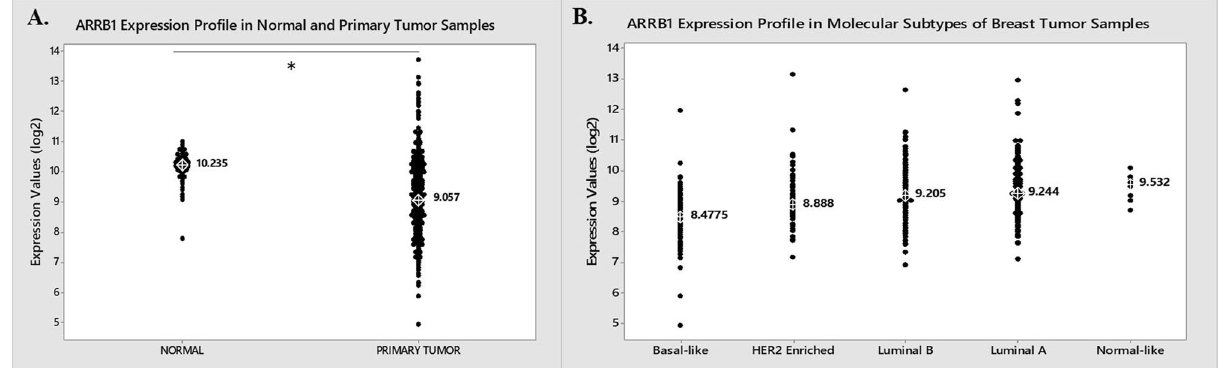
Figure 1. TGCA data analysis and downregulation of βArr1 expression in tumour samples. ( A ) The expression levels of βArr1 (ARRB1) in the clinical samples were assessed in breast tumour tissues and normal samples using the TCGA Breast Cancer BRCA data set ( n = 1211). The expression profiles of ARRB1 gene in 114 normal samples and 1097 primary tumour samples obtained from TCGA are shown in individual value plots. The median expression values are marked for each sample type, which is 10.235 for normal samples and 9.057 for the tumour samples. ARRB1 gene is significantly downregulated in tumour samples compared to normal samples (t-test; p = 1.35977E −33 ). ( B ) The expression profiles of ARRB1 gene in 98 Basal-like, 58 HER2-enriched, 127 Luminal B, 231 Luminal A and 8 Normal-like breast tumour samples obtained from TCGA are shown in individual value plots. The values given on the value plots are the median values for each sample type. According to ANOVA and Tukey’s post-hoc test result ARRB1 expression is significantly downregulated in Basal-like tumours compared to Normal-like, Luminal A, Luminal B or HER2-enriched subtype (ANOVA; * p <